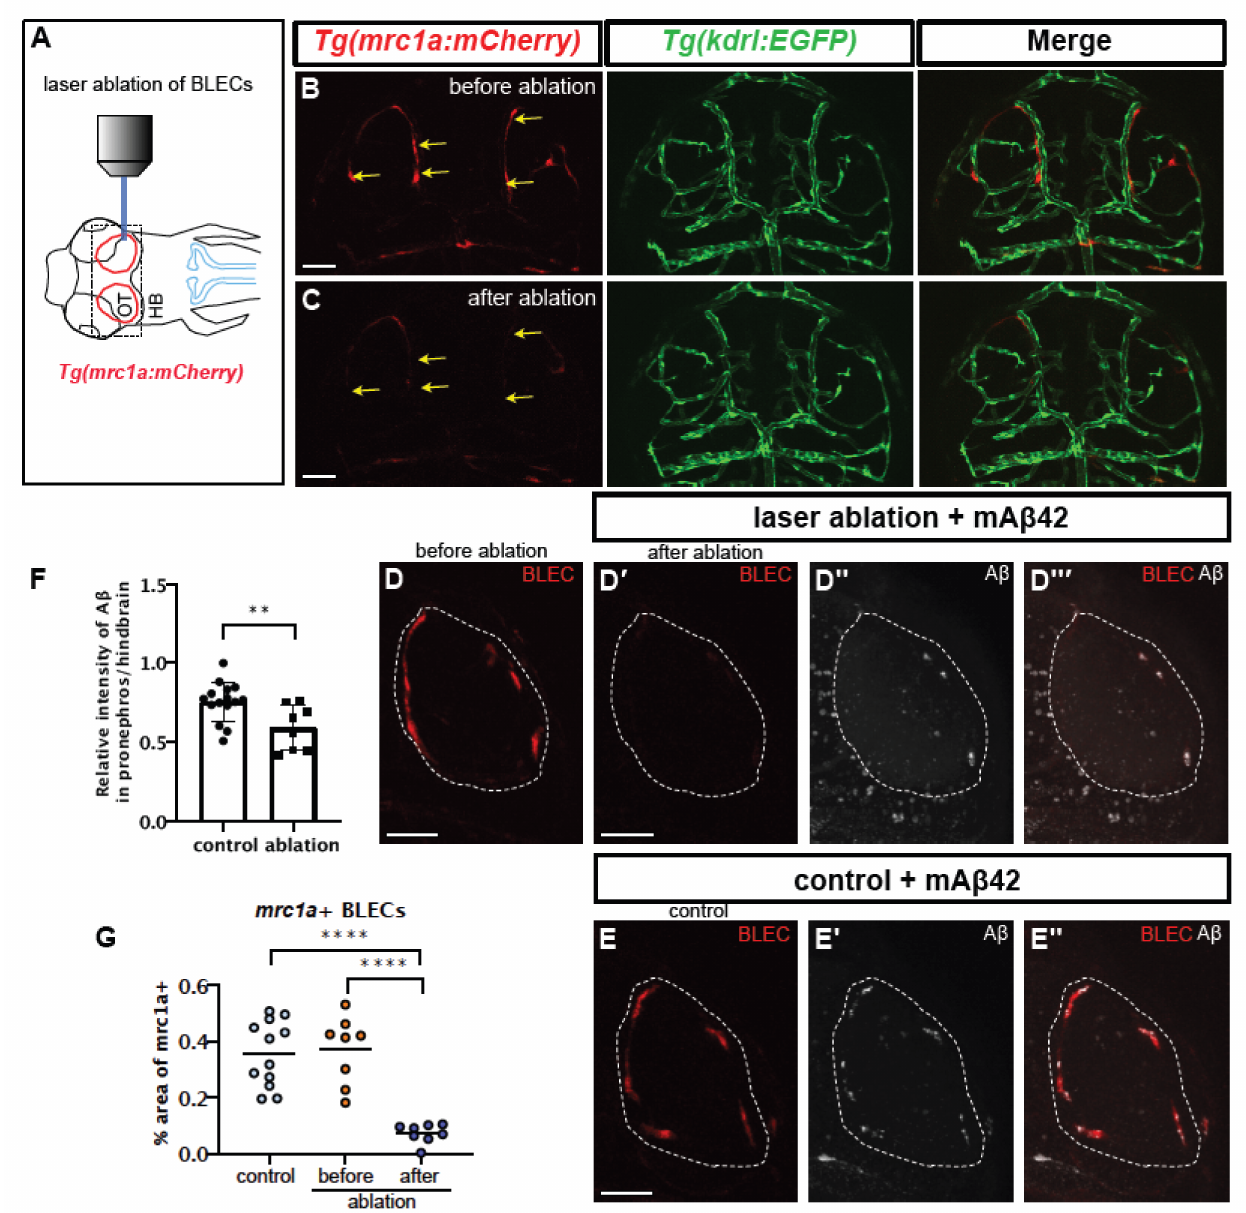
Figure 5. Selective ablation of BLECs decreased internalization of mA β 42 and pronephric accumulation. ( A ) A schematic diagram of the experimental setting. BLEC-specific ablation using the confocal laser. ( B , C ) Confocal images of BLECs in the double transgenic Tg ( mrc1a:mCherry ); Tg ( kdrl:EGFP ) at 3 dpf before laser irradiation ( B ) and after ablation ( C ). Yellow arrows indicate the ablated BLECs. Scale bars = 50 µ m. ( D ) Confocal images of mrc1a + BLECs in the loop of the optic before ablation ( D ) and after ablation and mA β 42 injection ( D (cid:48) – D (cid:48)(cid:48)(cid:48) ). ( D (cid:48) ) shows red channel, ( D (cid:48)(cid:48) ) shows mA β 42 (HiLyte647, white) and ( D (cid:48)(cid:48)(cid:48) ) is a merged image. Dotted lines denote the loop of BLECs. ( E ) Confocal images of mrc1a + BLECs with mA β 42 injection (non-ablated control). Scale bars = 50 µ m. ( E (cid:48) ) shows mA β 42 (HiLyte647, white) and ( E’’ ) shows merged images of BLECs and mA β 42. ( F ) Quantification of the relative intensity ratio between the pronephros and hindbrain. Data are presented as mean ± SEM. Statistical significance was determined by two-tailed unpaired t -test. n = 15 for non-ablated control, n = 8 for ablated. p = 0.0092. ( G ) Quantification of area fraction (%) occupied by mrc1a+ BLECs. Data are presented as mean ± SEM. Statistical significance was determined by ordinary one-way ANOVA with Tukey’s test. **, p < 0.01; ****, p <